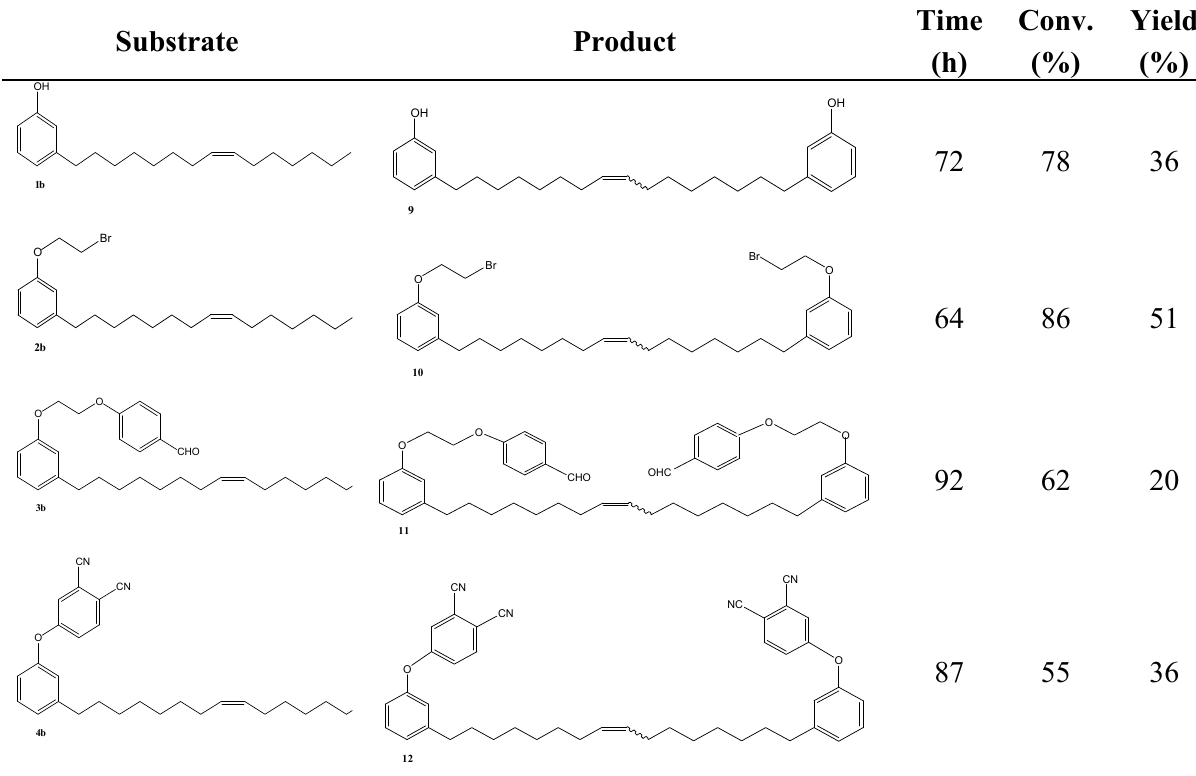
Table 1. Metathesis performed on cardanol 1 and cardanol derivatives 2–4